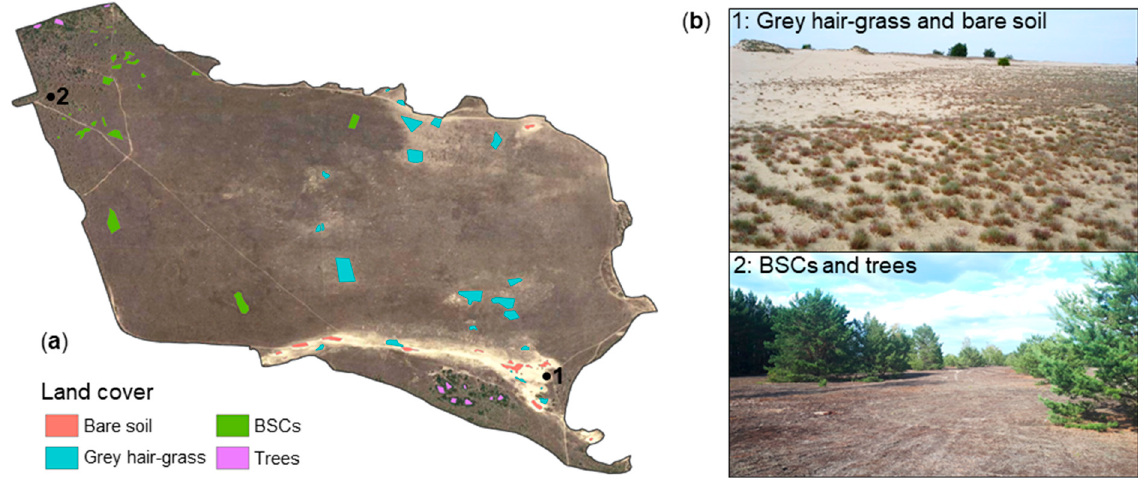
Figure 3. High-resolution true-color satellite imagery clipped to the extent of the study area with the reference areas for each of the four dominant land cover classes ( a ) and example pictures of each class ( b ).